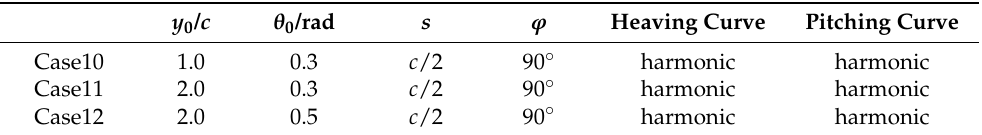
Table 2. Parameters of three working conditions.